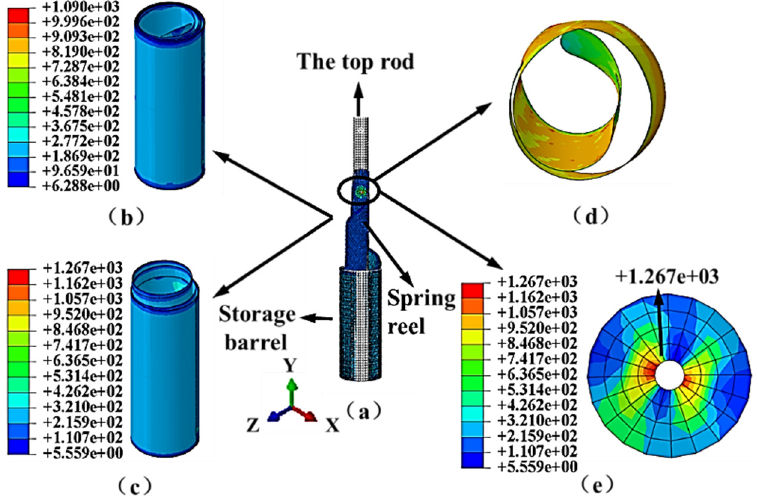
Figure 11. Influence of acceleration on the morphology and stress distribution of the spring reel with a friction coefficient of 0.1 between layers: ( a ) STACER model; ( b ) complete gathered state; ( c ) partial gathered state; ( d ) the morphology of the innermost circle; and ( e ) stress distribution.